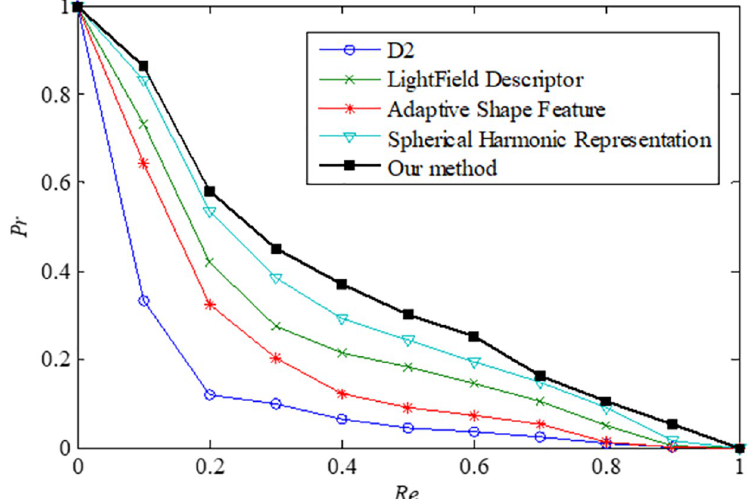
Fig 5. Precision vs. recall curves of our method and 4 other methods on our testing dataset. The horizontal axis represents recall rate, and the vertical axis represents precision rate. Higher curves represent better performance.